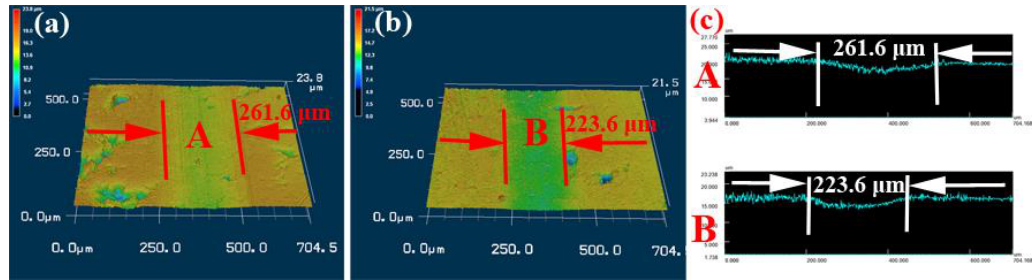
Figure 7. 2D and 3D profiles of NiCrAlY and NiCrAlY-Mo coatings: ( a ) NiCrAlY coating, ( b ) NiCrAlY-Mo coating, and ( c ) 2D profiles of the A and B regions.